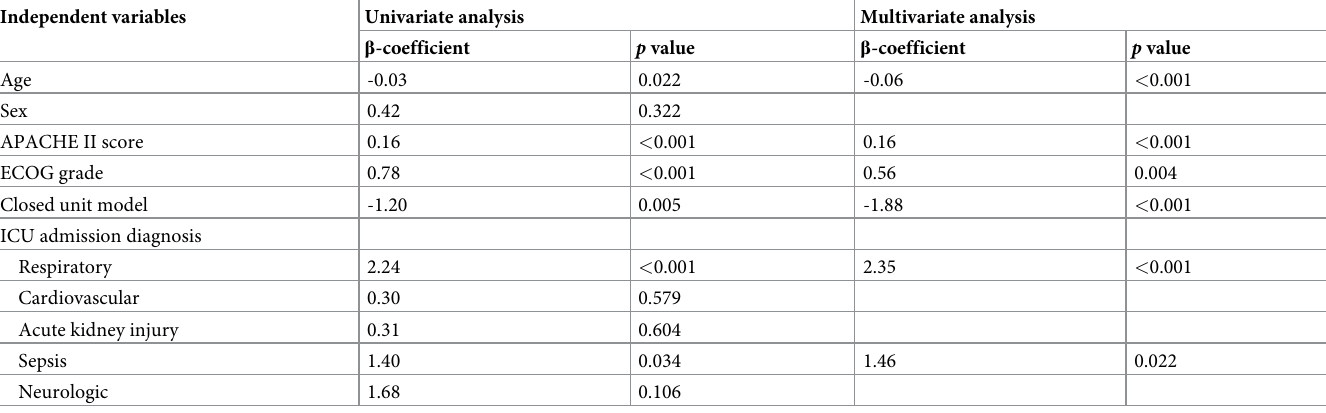
Table 4. Independent predictors of ICU length of stay among survivors by multiple regression